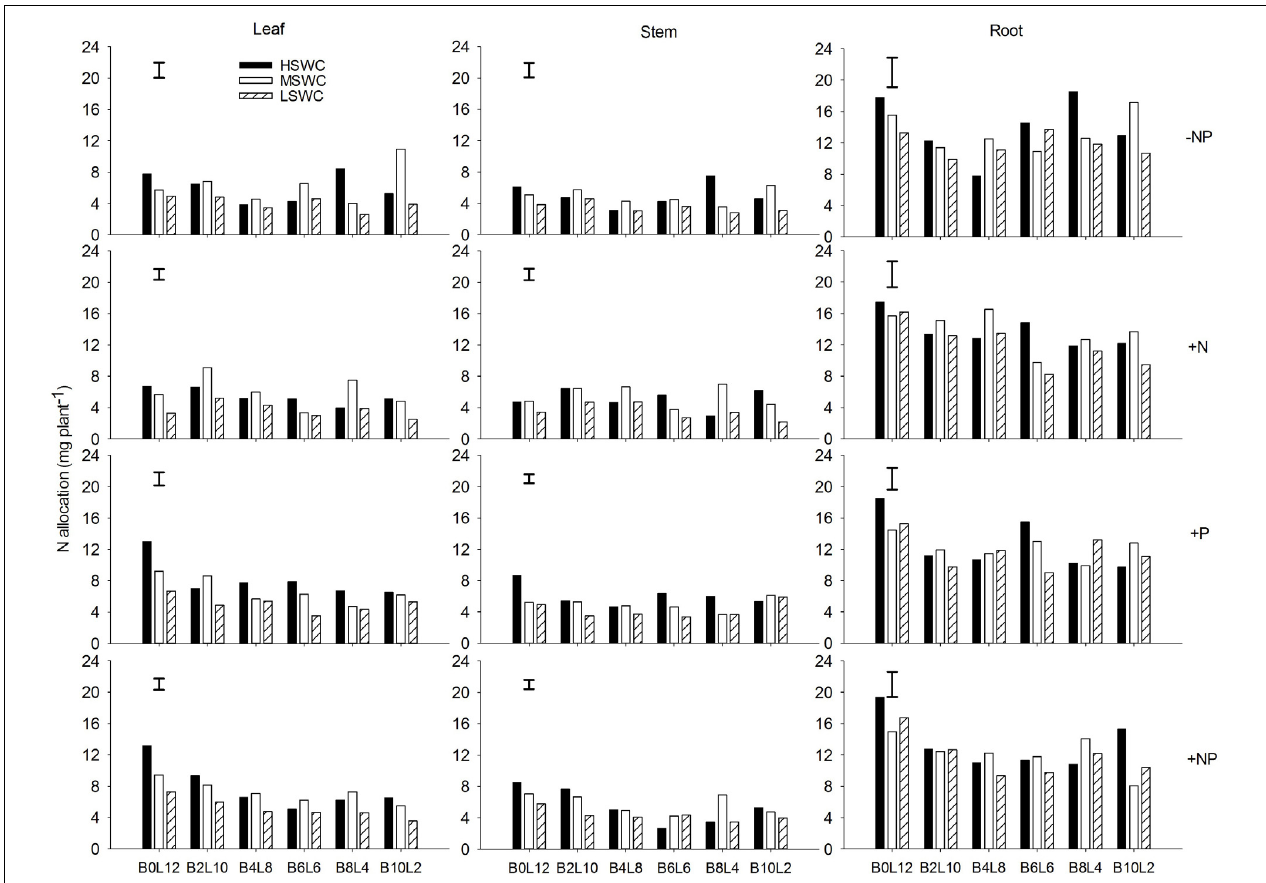
FIGURE 5 | N allocation in leaf, stem and root of L. davurica (L) mixed with B. ischaemum (B) at various mixture proportions under three soil water regimes [HSWC: 80% FC (field capacity); MSWC: 60% FC; LSWC: 40% FC] and four fertilization treatments (–NP, +N, +P, +NP). B i L j ( i , j = 0, 2, 4, 6, 8, 10, 12; i + j = 12) means the plant numbers of B. ischaemum to L. davurica in their mixtures. Error bars are LSD ( p <